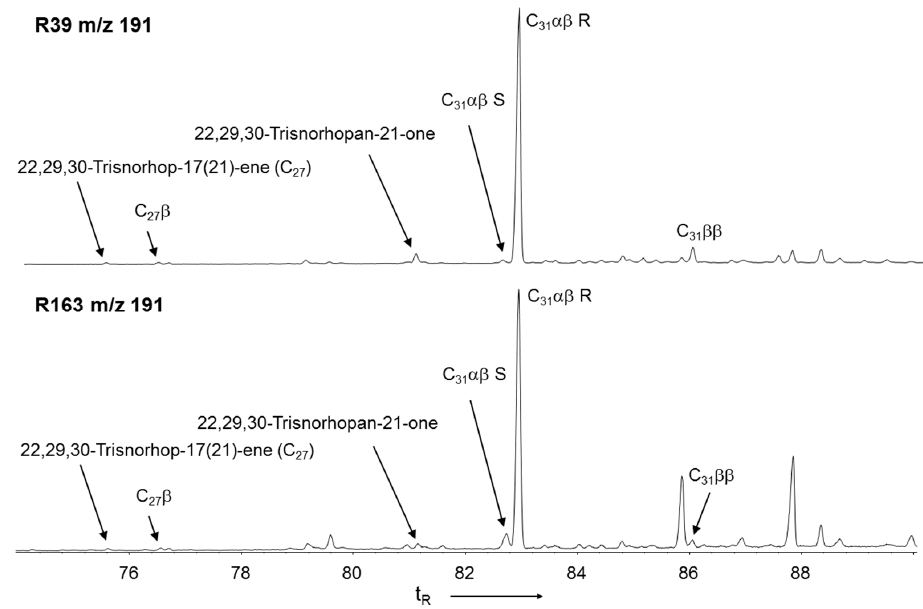
Figure 6. m / z 191 traces of two selected samples from the upper and lower part of the Roñanzas profile at 39 and 163 cm (R39 and R163) in the high retention time where hopanoids appear.